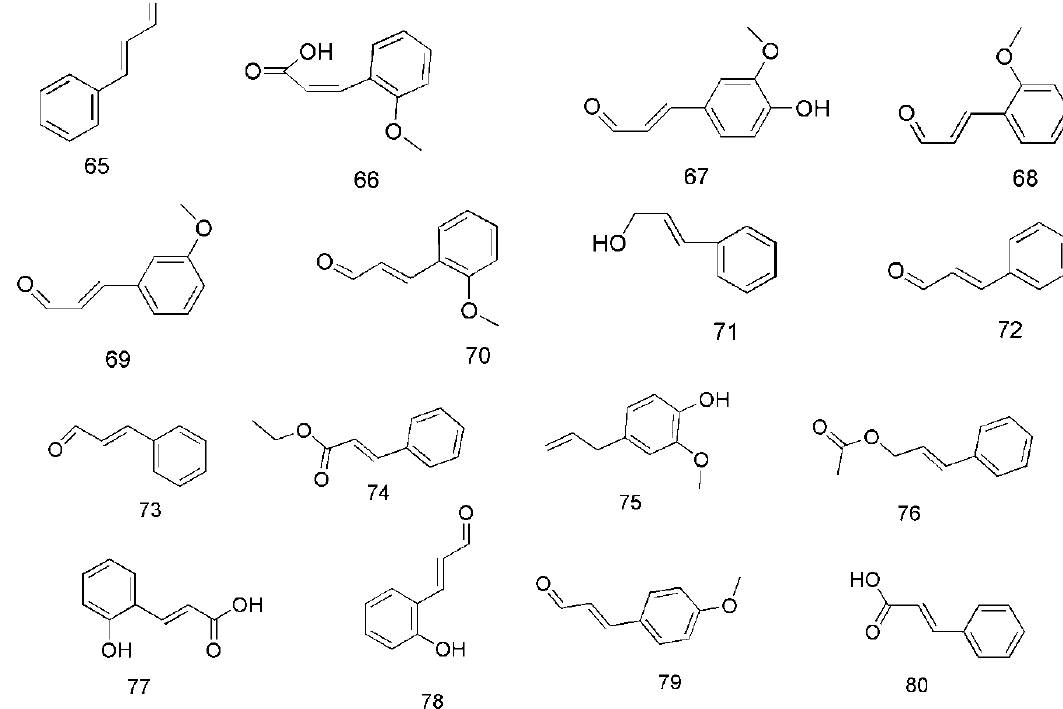
Figure 5. Chemical structures of the phenylpropanoids in C. cassia .